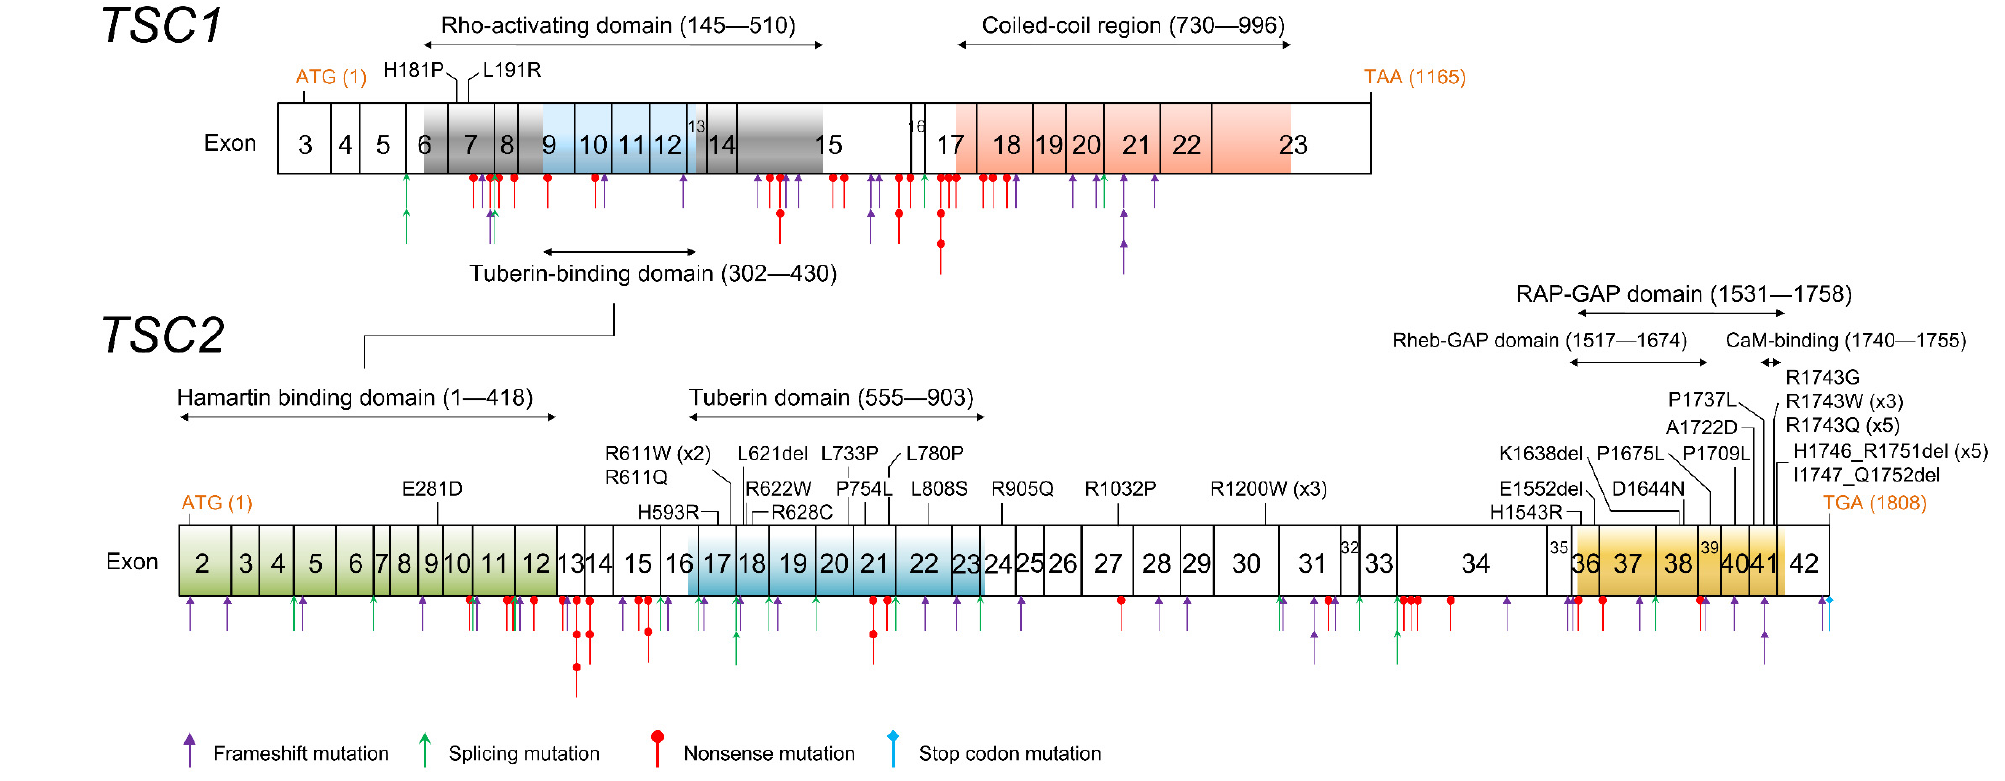
Figure 4. Distribution of TSC1 and TSC2 point mutations. Missense and in-frame mutations are indicated in the upper lane of each gene’s schema. In contrast to the protein truncated mutations diffusely distributed in both TSC1 and TSC2 , missense and in-frame mutations are concentrated in functional domains.